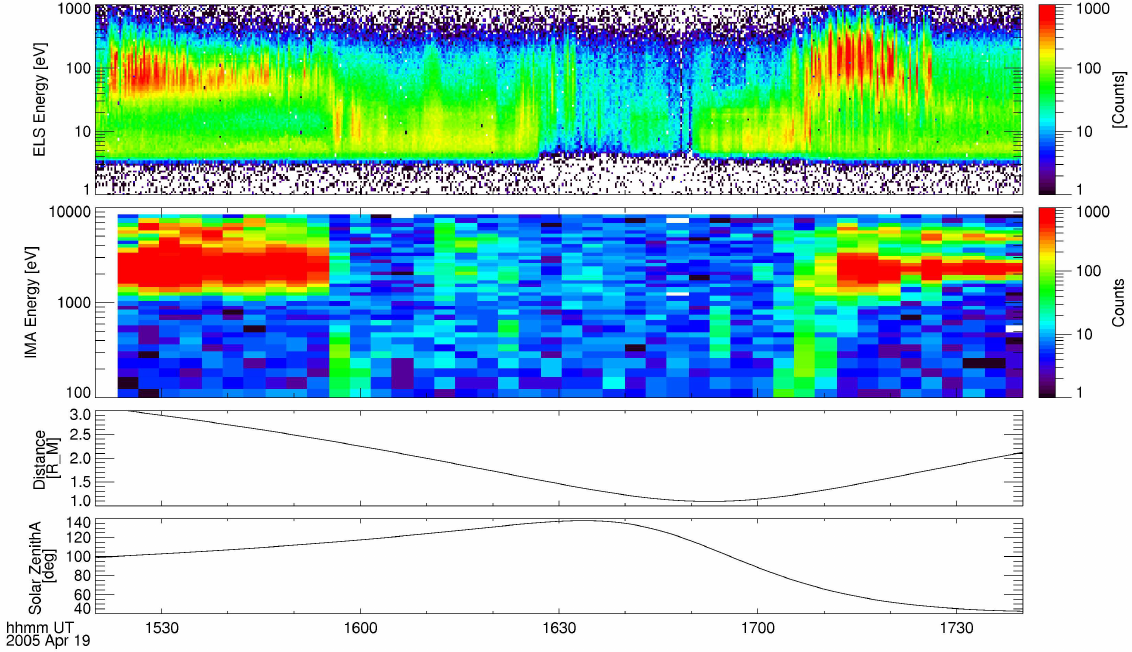
Fig. 2. Mars Express energy spectra of electrons (a) and ions (b) for the orbit No. 1614 on 19 April 2005. The two bow shock crossings appear 15:25 UT and 17:25 UT. Between 15:55 UT and 17:08 UT, the spacecraft pass a region of cold ionospheric plasma. Significant densities of heavy ions occur at the flanks of the